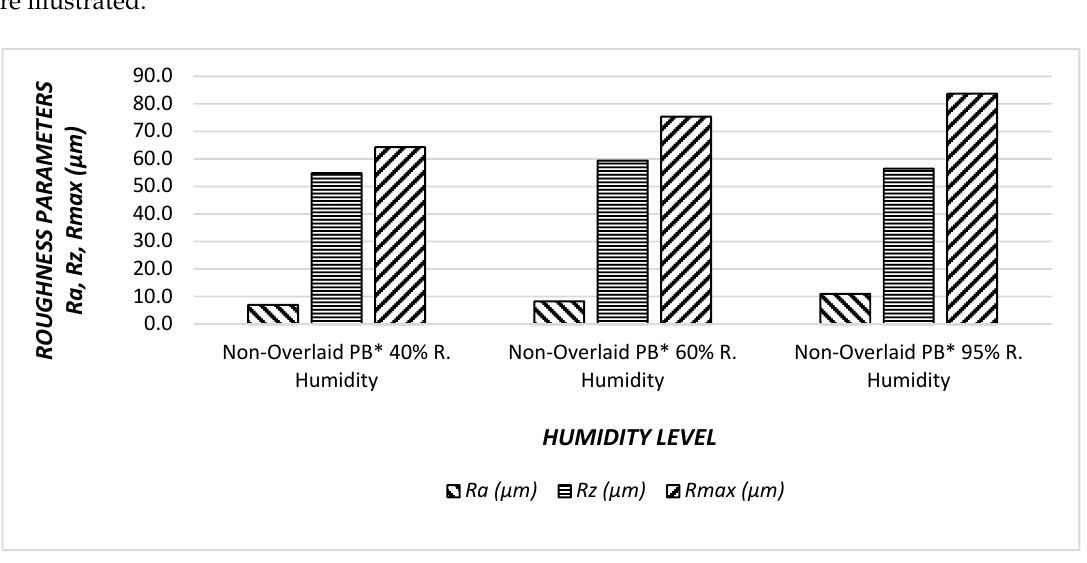
Figure 8. Surface roughness values (R a , R z , R max ) of the non-overlaid particleboard (PB). Under effect of humidity.